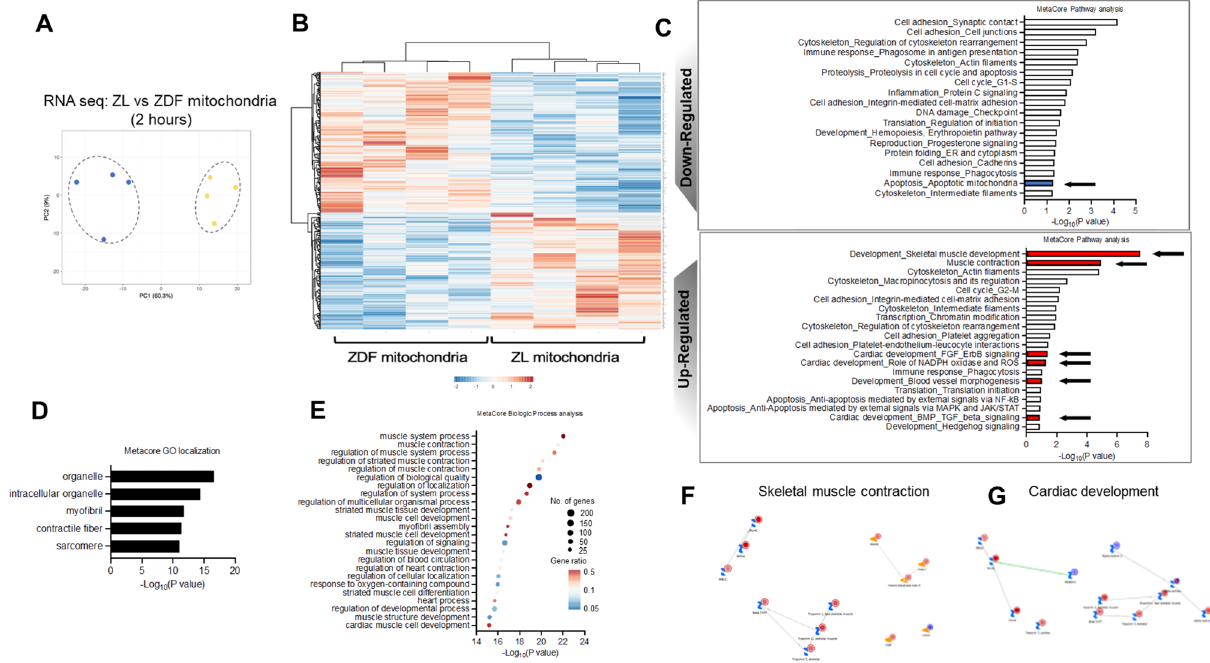
Figure 6. Transcriptomic pathways following 30 min of regional myocardial ischemia and 2 h reperfusion. ( A ) Principal component analysis (PCA) for hearts receiving diabetic ZDF- (gold circles) or non-diabetic ZL -mitochondrial transplantation (blue circles) as compared to hearts receiving vehicle alone. ( B ) Heatmap of transcriptional regulation patterns following 30 min IRI and 2 h recovery, for hearts receiving diabetic ZDF- or non-diabetic ZL -mitochondrial transplantation. Fold changes (FC) are derived from comparison to Vehicle hearts. The log FC of gene expression is shown with pseudocolor scale (− 2 to 2), with blue denoting downregulation and orange denoting upregulation. Columns represent FC comparisons, and rows represent the genes. Experimental groups are found on the bottom. ( C ) A barplot summarizing the top downregulated and upregulated pathways. Colored barplots Red and blue, shown by arrows, indicate the pathways of interest. ( D ) Gene set enrichment analysis using MetaCore localization networks for hearts receiving diabetic ZDF- or non-diabetic ZL -mitochondria. ( E ) Gene set enrichment analysis using MetaCore biologic process analysis of non-diabetic ZL- as compared to diabetic ZDF- mitochondrial transplantation. Color coding indicates the gene ratio (orange higher-blue lower) and size of the dot indicates the number of the genes. Gene network visualization of ( F ) “Skeletal muscle development” and ( G ) “Cardiac development” pathways showing a central node of troponins . Node sizes are proportional to the number of dataset proteins present in that pathway node. Node color and scale bars depict the level of betweenness centrality for that pathway